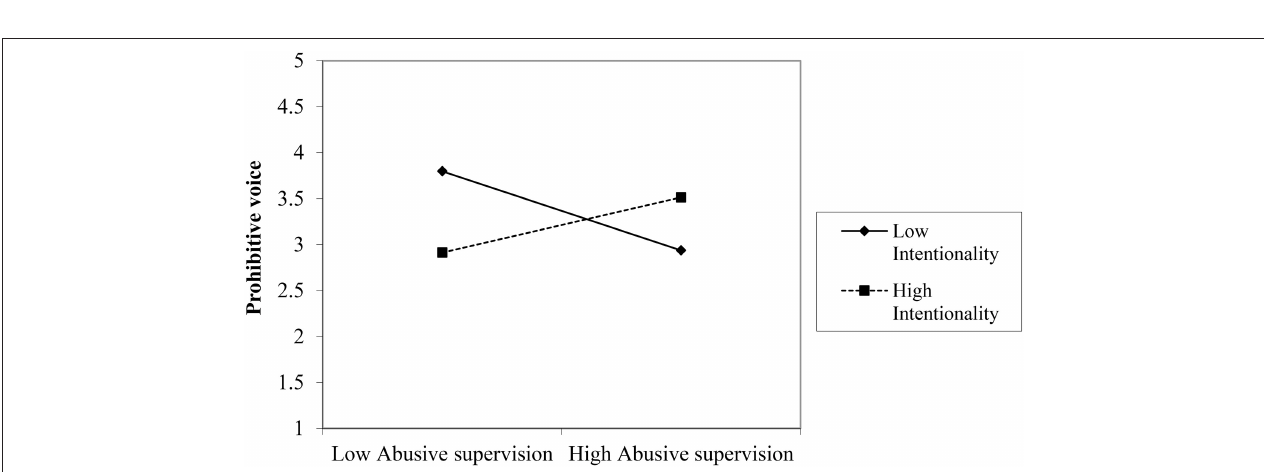
FIGURE 7 | Interaction between abusive supervision and attribution to the supervisor on prohibitive voice (Study 2).